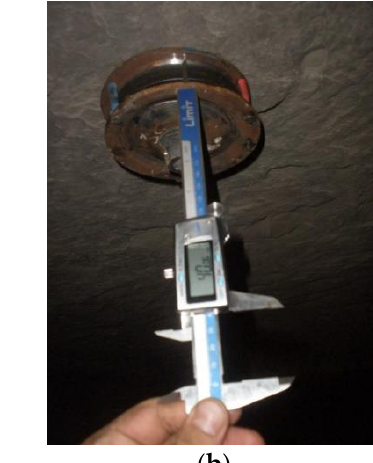
Figure 12. Measurement of the rock bolt load in the exploitation room: (a) Arrangement of sensors; (b) Indirect load measurement.